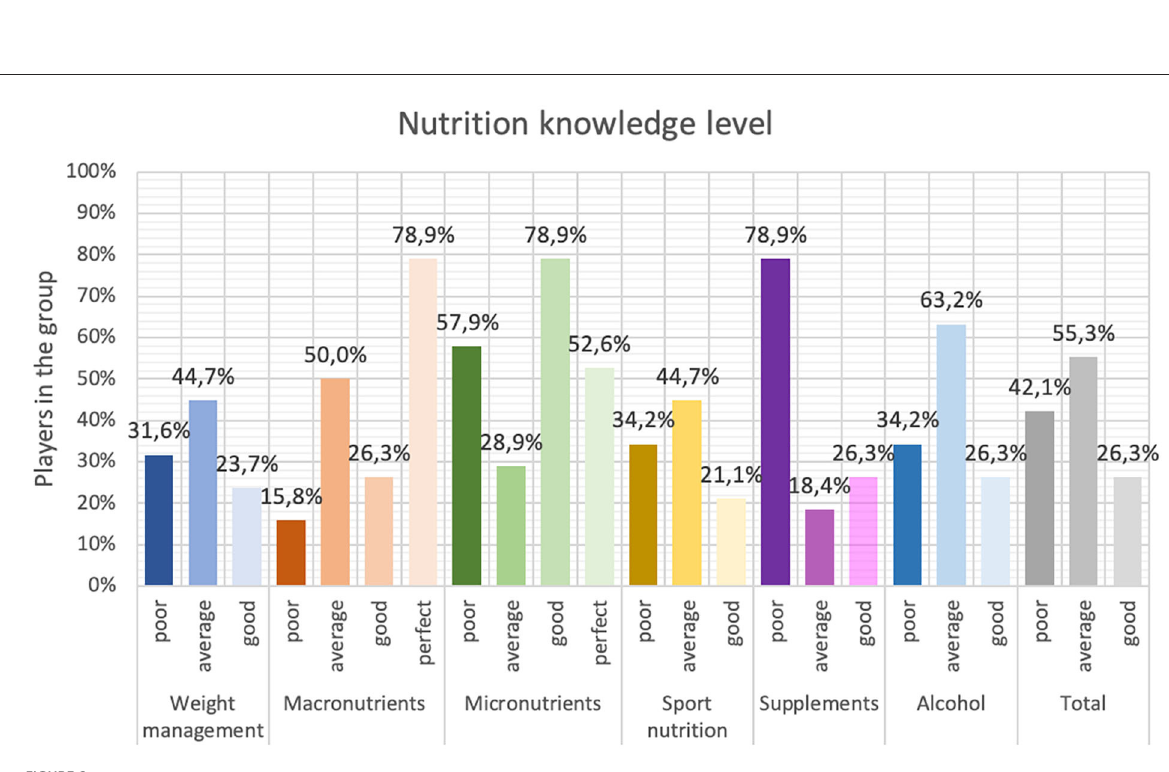
FIGURE6 Nutrition knowledge of the football players participating in the study ( n =